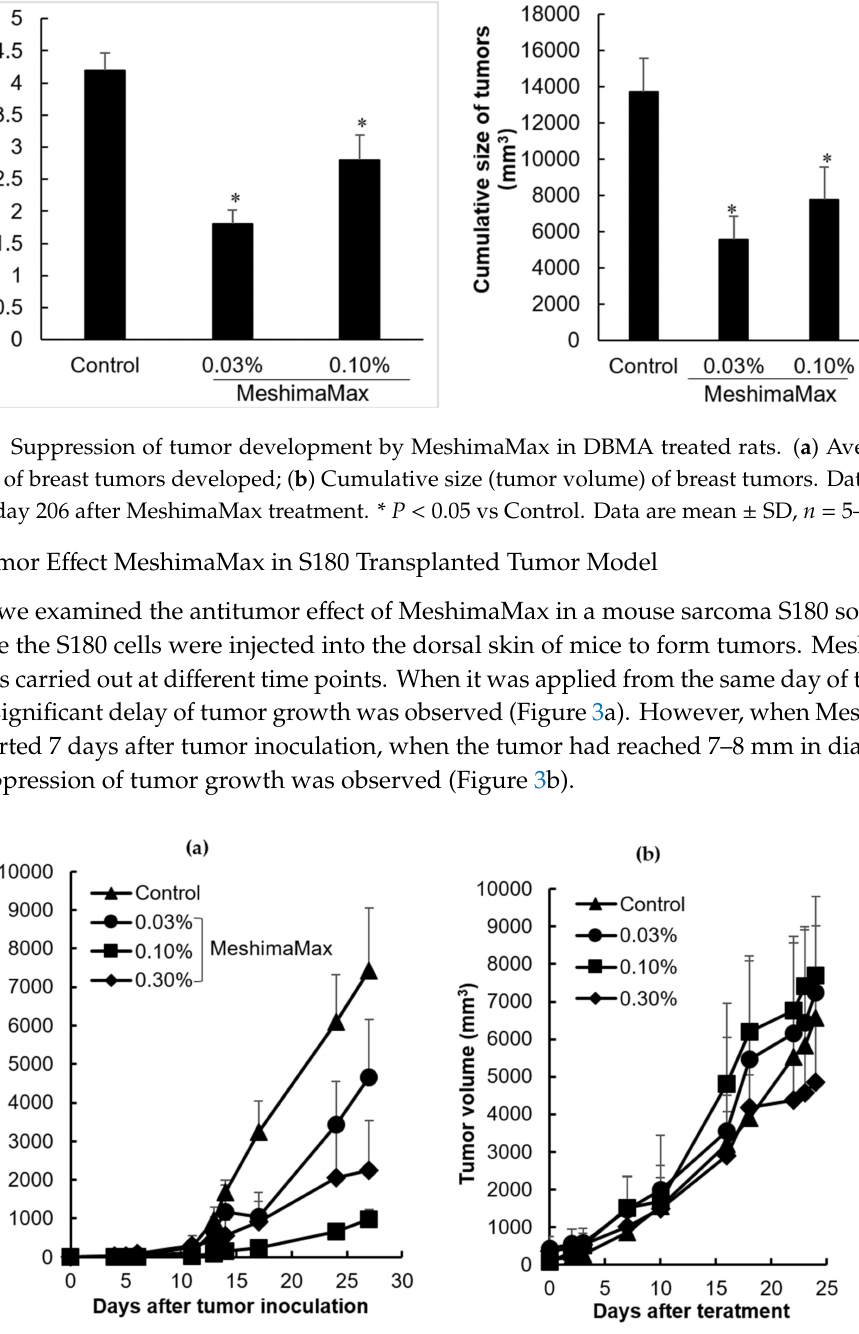
Figure 3. Antitumor e ff ect of MeshimaMax against mouse sarcoma S180 solid tumor. ( a ) MeshimaMax treatment was carried out from the day of S180 tumor cell inoculation; ( b ) MeshimaMax treatment was carried out from day 7 after S180 tumor cell inoculation when tumor had grown to 7–8 mm in diameter. Data are mean ± SD, n =